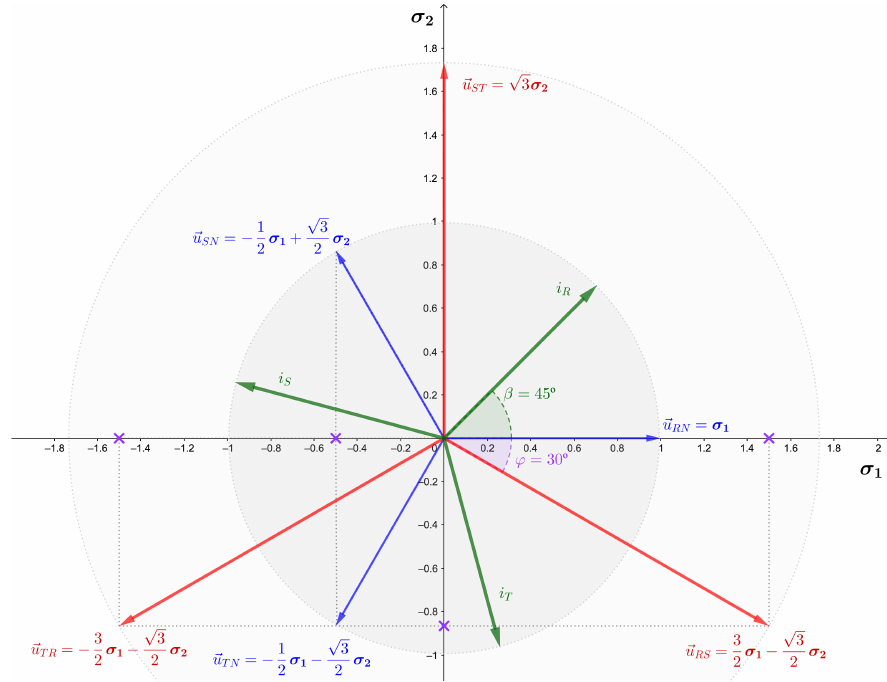
Figure 3. Representation of voltage and current geometric vectors in the plane σ 1 σ 2